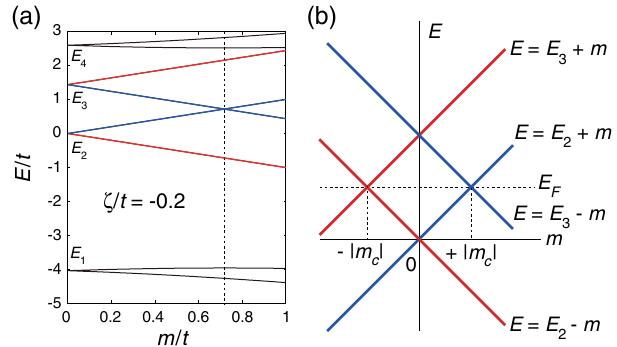
FIG. 10. Level scheme of the L point and its dependence on the all-in — all-out order parameter. (a) Level splitting at the L point due to the finite order parameter m . Here, the four doublets are ffiffiffi p 2 ζ − located at E 1 ¼ − t − , for m ¼ 0 . The vertical dashed line shows m ¼ j m , for which c j the bulk Weyl points are annihilated in pairs. The two blue (red) states show the states adiabatically connected to the states that form the domain-wall state at m ¼ m ( m ¼ − m ). Namely, the c c two blue (red) lines indicate the two solutions of the 2 × 2 low- ˆ ˆ − Þ h ðþÞ h ð energy Dirac Hamiltonian ( ) (E7). See (b) for a more L L focused illustration. (b) Level splitting focused on the low-energy states, around the chemical potential. The blue states around the Fermi level E form a domain-wall state confined in the side of F the positive magnetization, while the red states around the Fermi level are confined in the opposite m < 0 side of the domain wall. [See discussions below Eq.